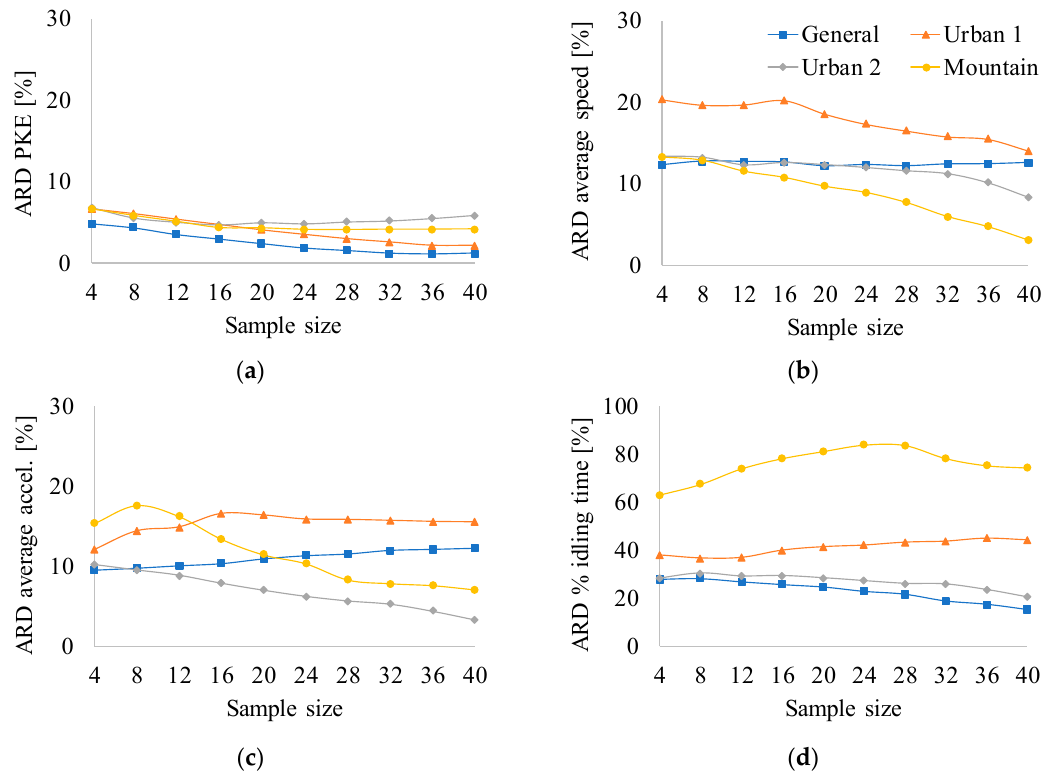
Figure 2. Average relative differences (ARD) of common characteristic parameters (CPs) used to describe driving cycles ( DC ) as a function of the number of trips sampled and the type of regions used in this study. ( a ) positive kinetic energy ( PKE ); ( b ) average speed; ( c ) percentage of time with positive acceleration; ( d ) percentage of idling time.